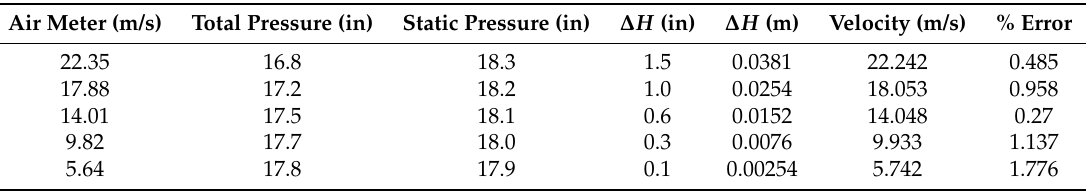
Table 4. Wind tunnel velocity calibration. Velocity inside the test section was calibrated with pitot-static tube and inclined air